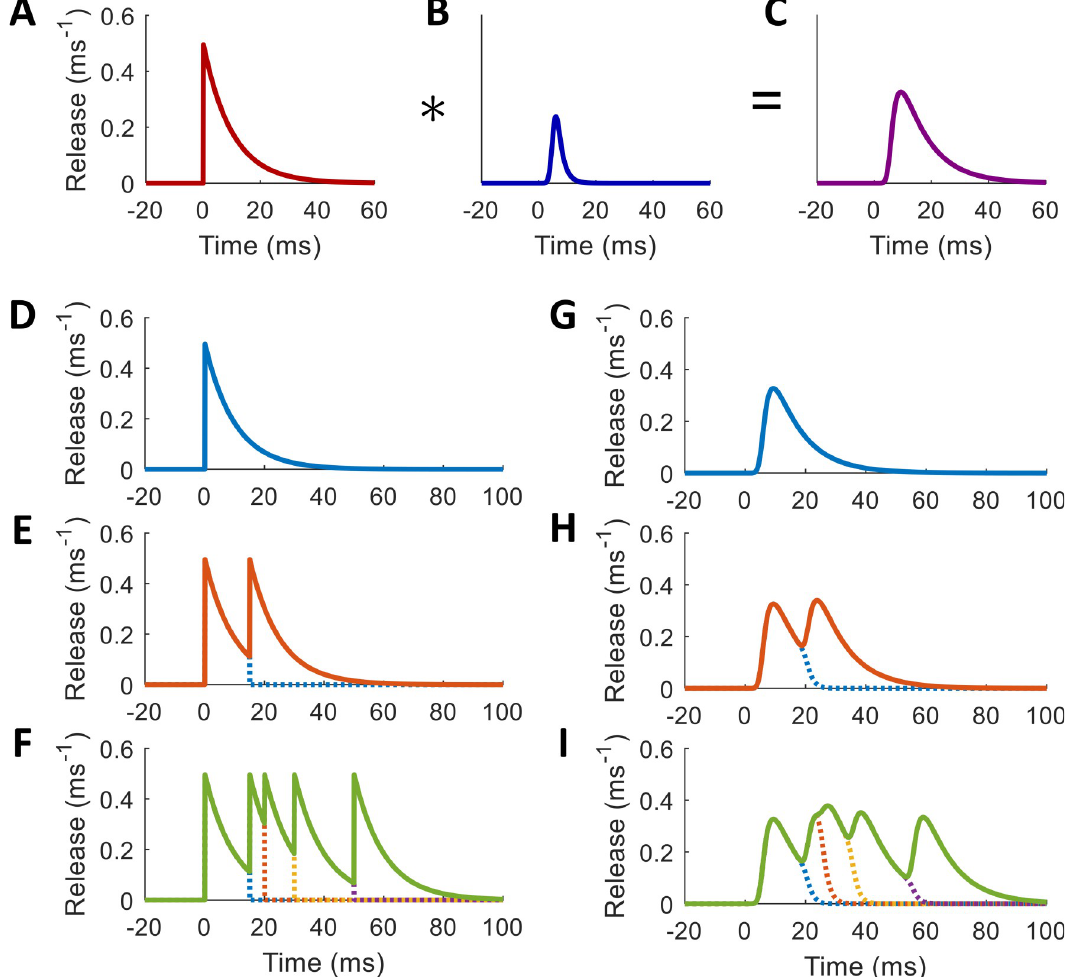
Fig 8. Convolutional Filter Applied to a Component of a Release Rate Function. Toy model with P = 5, τ = 10 ms, k = 0.5 ms –1 , μ = 5 ms, and σ = 1 ms. (A) Unfiltered release rate component. (B) MCMC ex-Gaussian filter shape. (C) Filtered release profile produced by convolving the release rate profile with the temporal delay filter. (D-F) Release rates in response to spike trains without applying delay filter. (G-I) Release rates in response to spike trains with delay filter applied. (D,G) Response to one spike. (E,H) Response to two spikes. (F,I) Response to multiple spikes. Dotted lines show how the histogram of response to one spike falls off with interference from the response to the following spike. Spike times at 0, 15, 20, 30, and 50 ms.